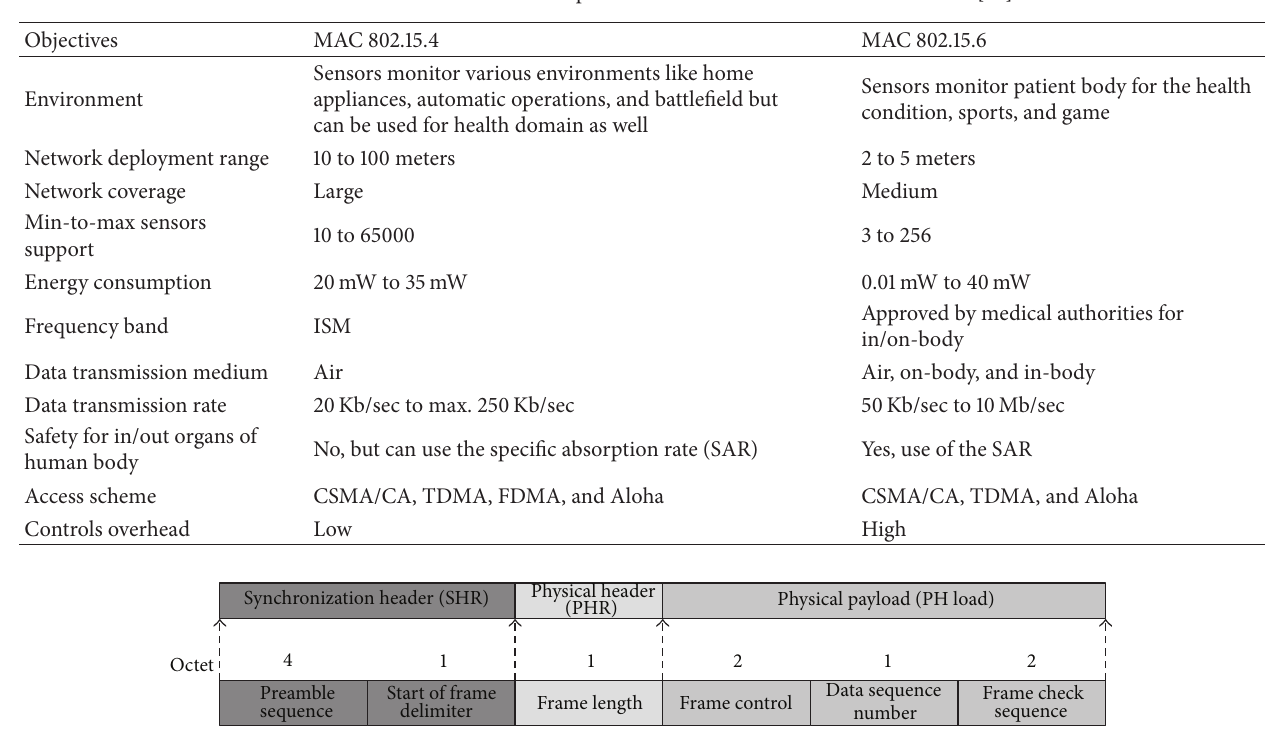
Table 3: MAC functionalities comparison of IEEE 802.15.4 and IEEEE 802.15.6 [22].